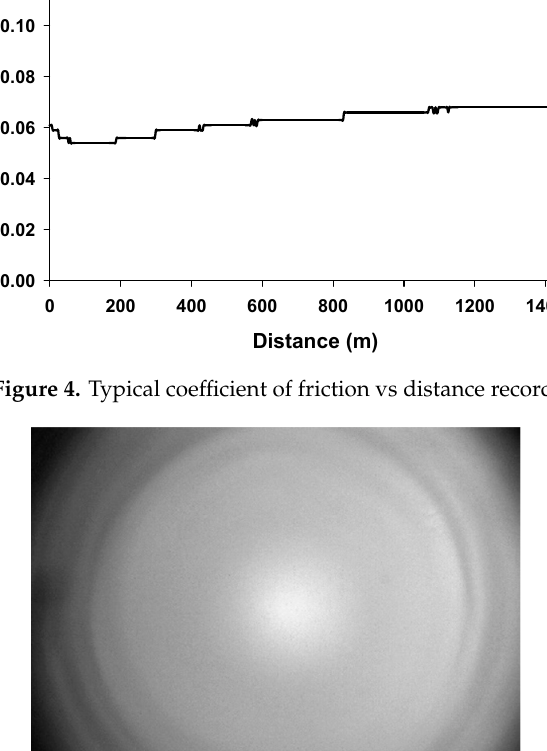
Figure 5. Optical micrograph of the sapphire ball after a tribological test.